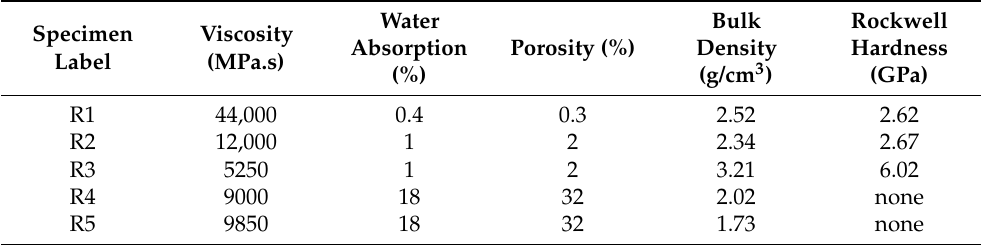
Table 8. The results of viscosity and mechanical properties at different alkaline solution ratios. Specimen